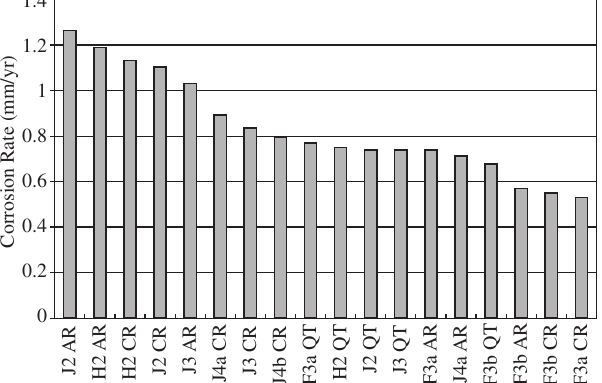
60 kg Melts Shown in Order of Corrosion Rate at pH 5.4